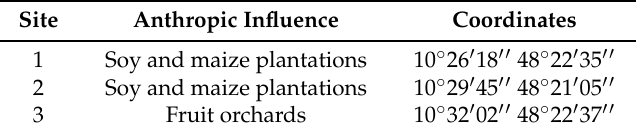
Table 1. Contributions of rural activities in each collection site in Tocantins River, Brazil.